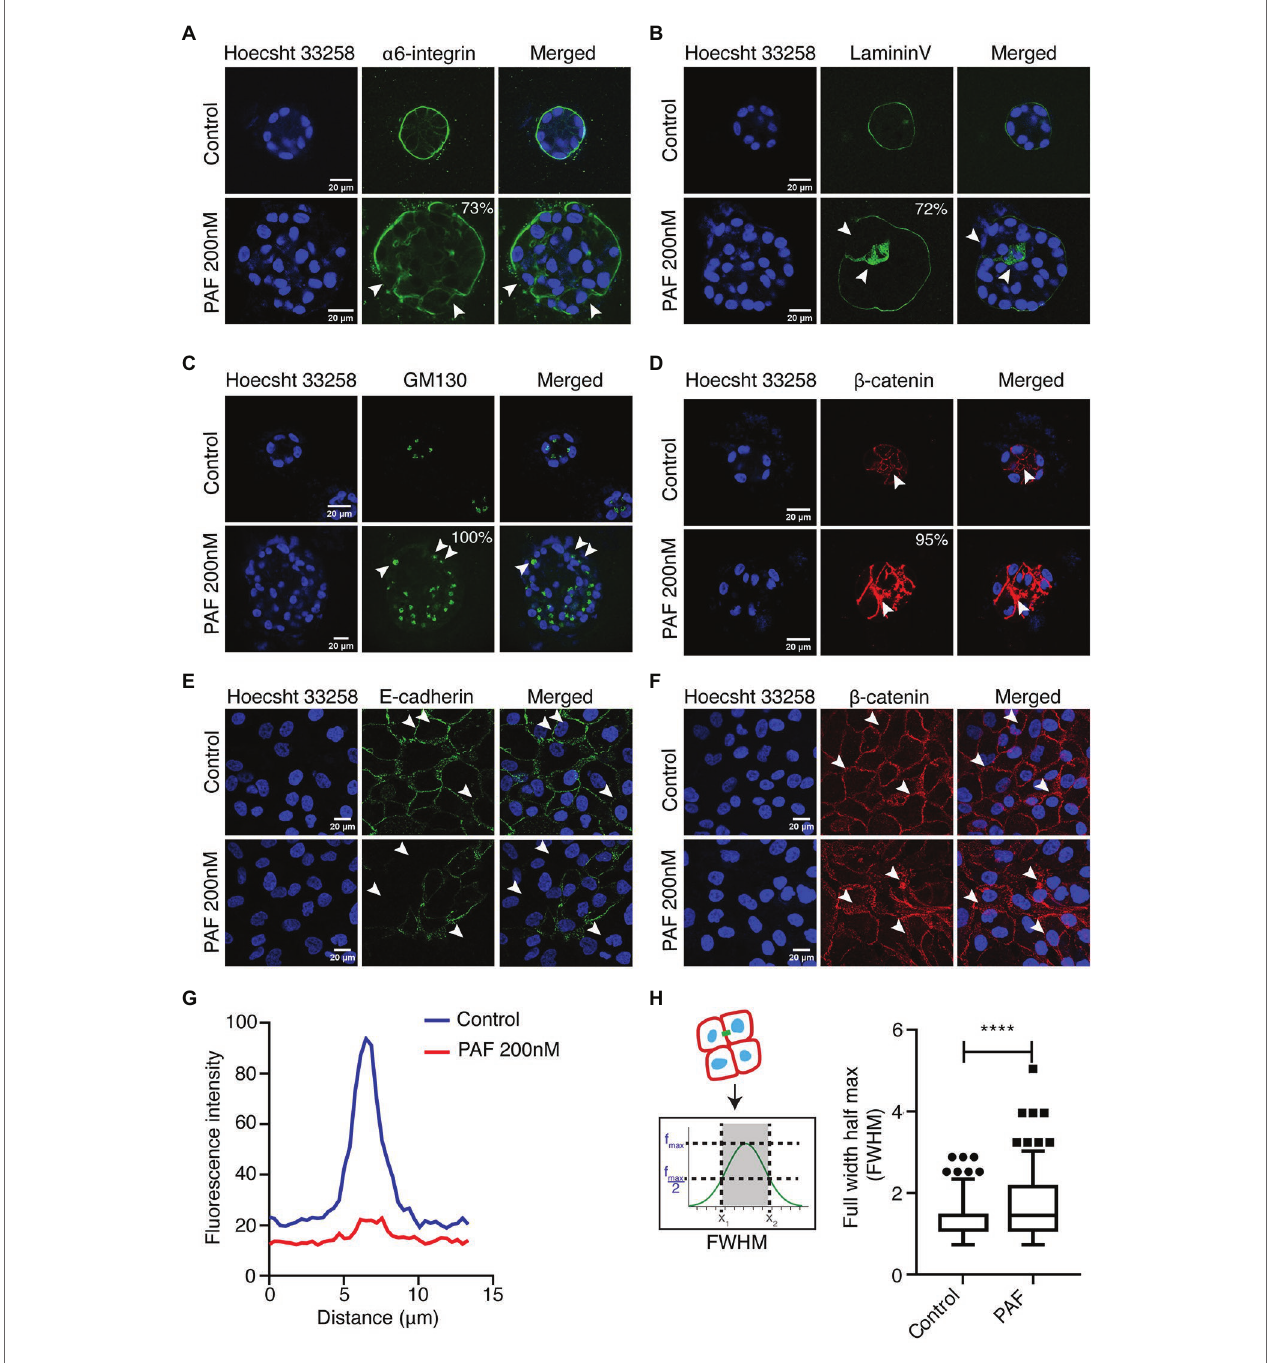
FIGURE 2 | PAF treatment alters acinar polarity and leads to the disruption of cell-cell junctions. PAF-treated 20 days 3D cultures of MCF10A were immunostained with polarity and cell-cell junction markers. Nucleus is stained with Hoecsht 33,258 (blue). (A) Immunostained images of α 6-integrin (green) marks the basal polarity ( N = 4). (B) Immunostained images of LamininV (green) marks the basement membrane of the acini ( N = 4). (C) Immunostained images of GM130 (green) marks apical polarity ( N = 3). (D) Immunostained images of β -catenin (red) marks the cell-cell junctions. (E) Dissociated cells of control and PAF-treated acini immunostained with E-cadherin (green), a cell-cell junction marker and the image is a representative of the phenotype ( N = 3). (F) Dissociated cells of control and PAF treated acini immunostained with β -catenin (red), a cell-cell junction marker and the image is a representative of the diffused phenotype ( N = 3). (G) Median fluorescent intensity of E-cadherin line profile showing loss phenotype. (H) FWHM profile of β -catenin line profile showing diffused phenotype. The phenotypes are quantified from N > 3 set independent experiments. Statistical analysis was performed for (H) using Mann Whitney U test; ***** p <